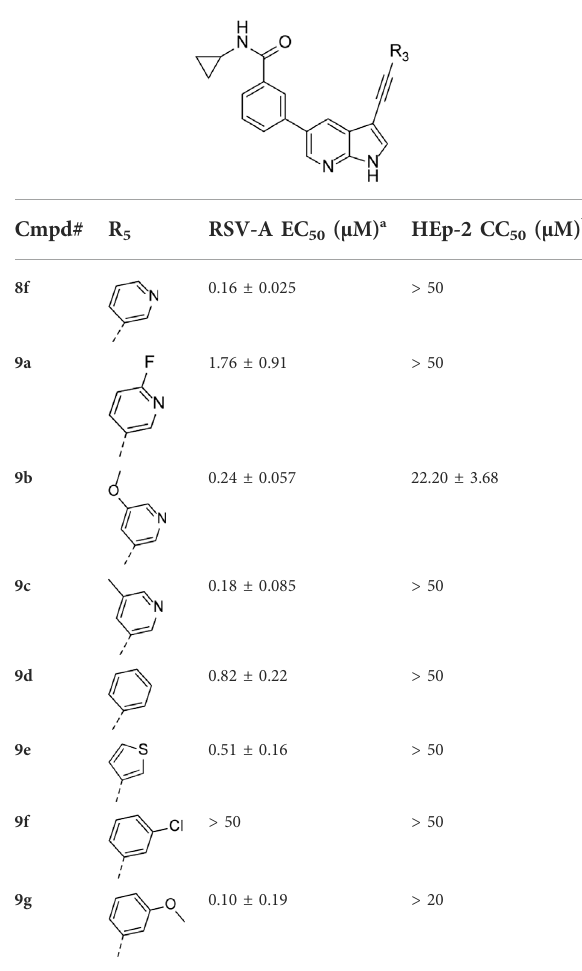
TABLE 6 Anti-RSV activity and cytotoxicity of 5- ( N -cyclopropylbenzamide)-3-alkynyl-pyrrolo[2,3- b ]pyridines